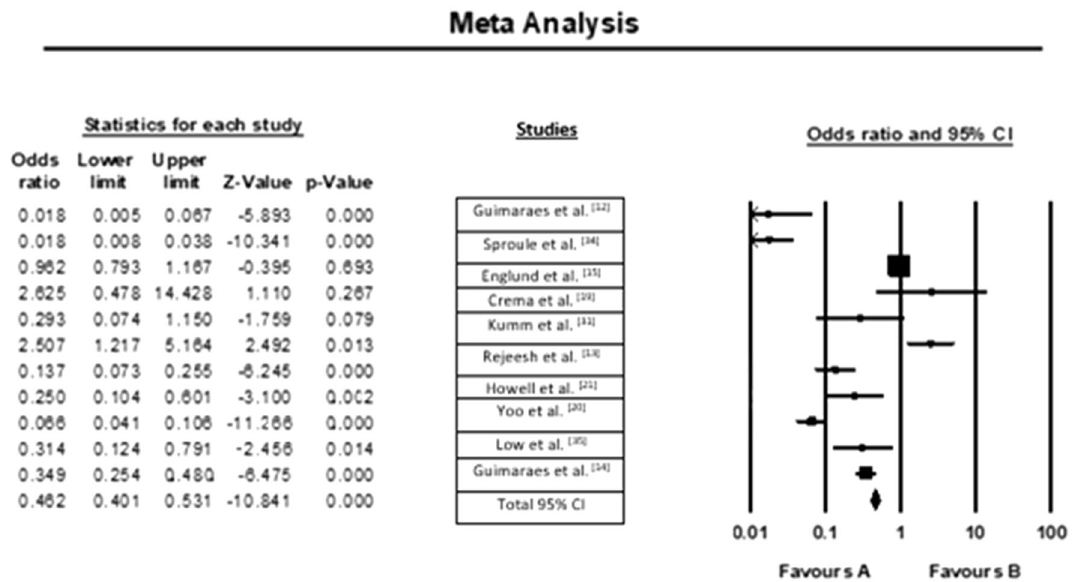
Figure 4. Risk of bias summary.